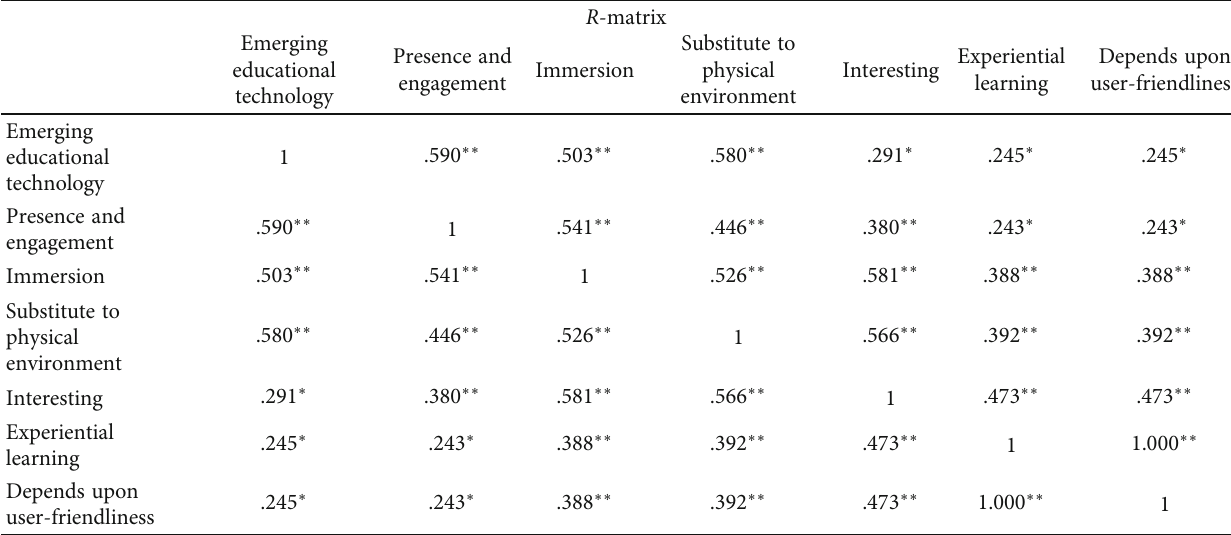
Table 1: Constructing validity result.